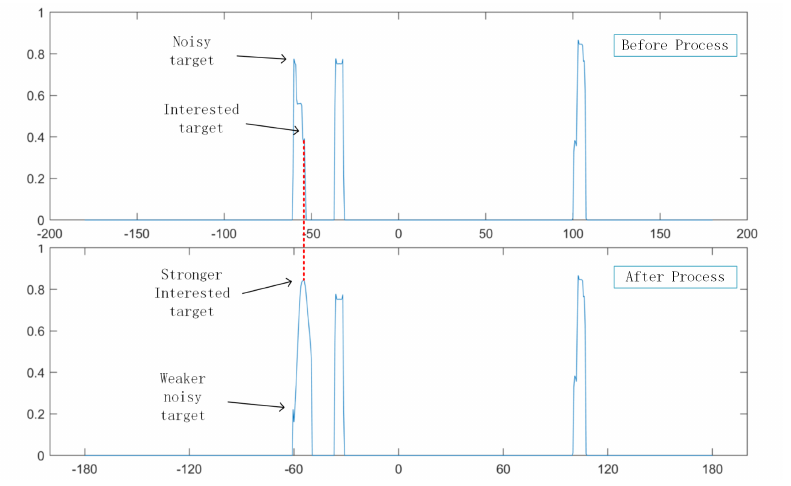
Figure 7. A single snap of